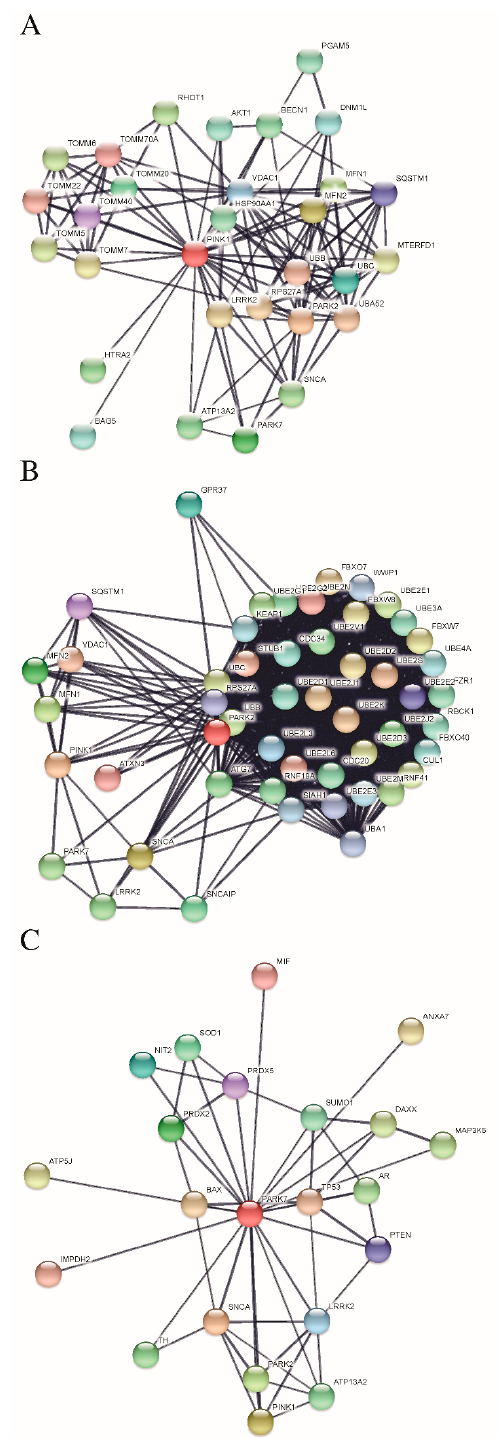
Figure 4. STRING analysis reveals protein interaction networks of the proteins DJ-1 (PARK7) ( A ), PINK1 ( B ) and PARKIN (PARK2) ( C ) with other proteins. The interaction network was created with STRING (Search Tool for the Retrieval of Interacting Genes/Proteins) database version 10.5. A high confidence cutoff of 0.7 was implemented in this work. In the resulting protein association network, proteins are presented as nodes which are connected by lines whose thickness represents the confidence level